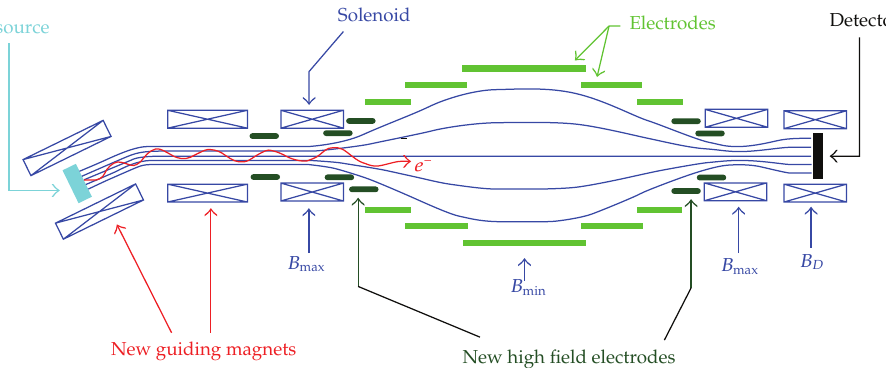
Figure 10: The upgraded Mainz setup shown schematically. The outer diameter amounts to 1m, the distance from source to detector is 6m.